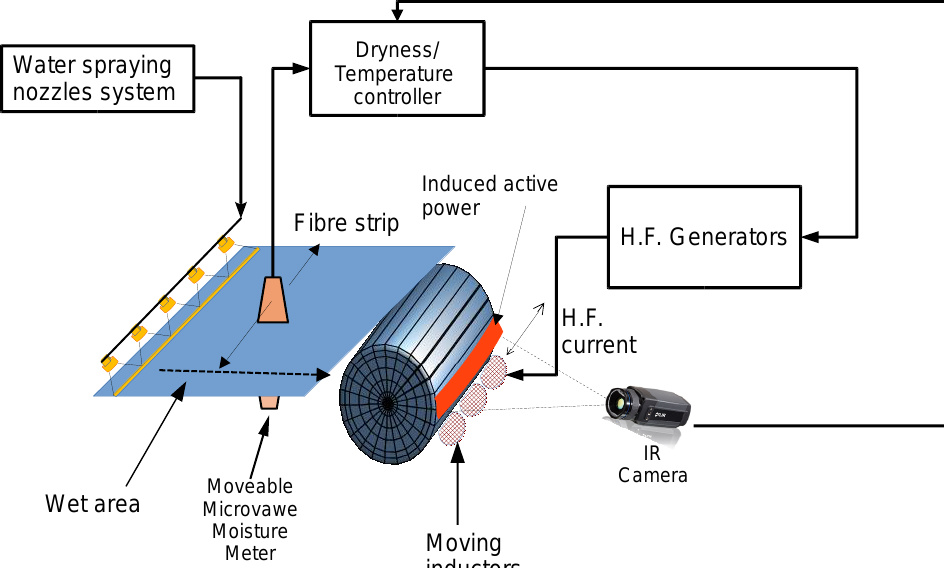
Figure 1. Schematic diagram of the system for the automatic drying of wet fiber tape.